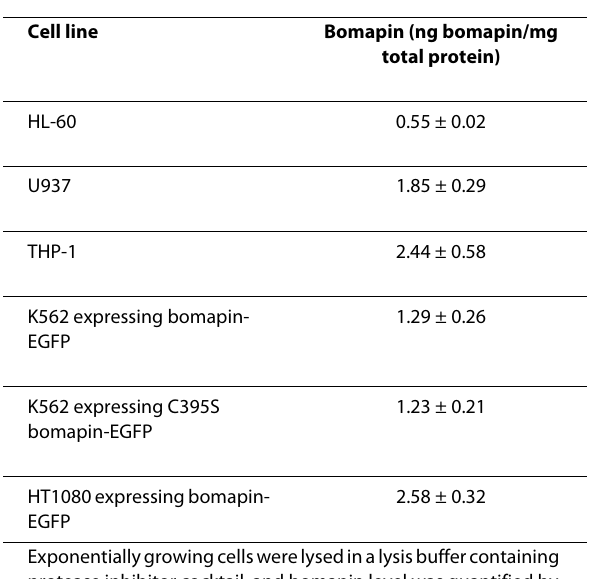
Table 1: Expression levels of natural and recombinant bomapin in cells